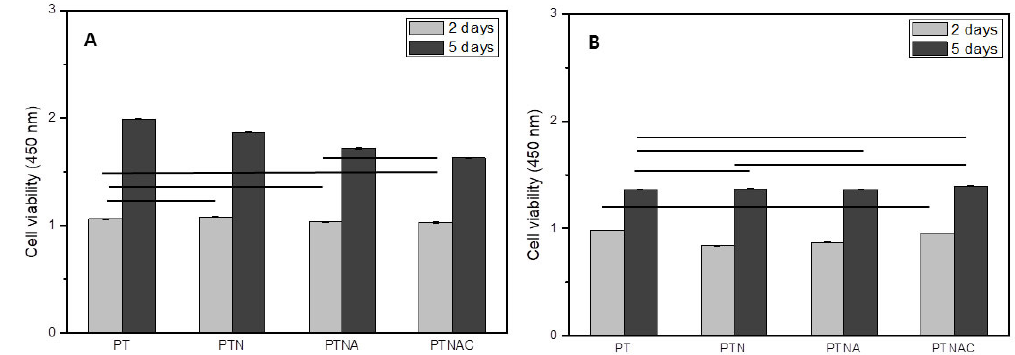
Figure 6. WST assay of ( A ) cell proliferation on the PT, PTN, PTNA, and PTNAC surfaces after cells were cultured for 2 and 5 days; ( B ) adhered cells on the PT, PTN, PTNA, and PTNAC surfaces with 0.02% TryLE™ Express treatment for 5 min.